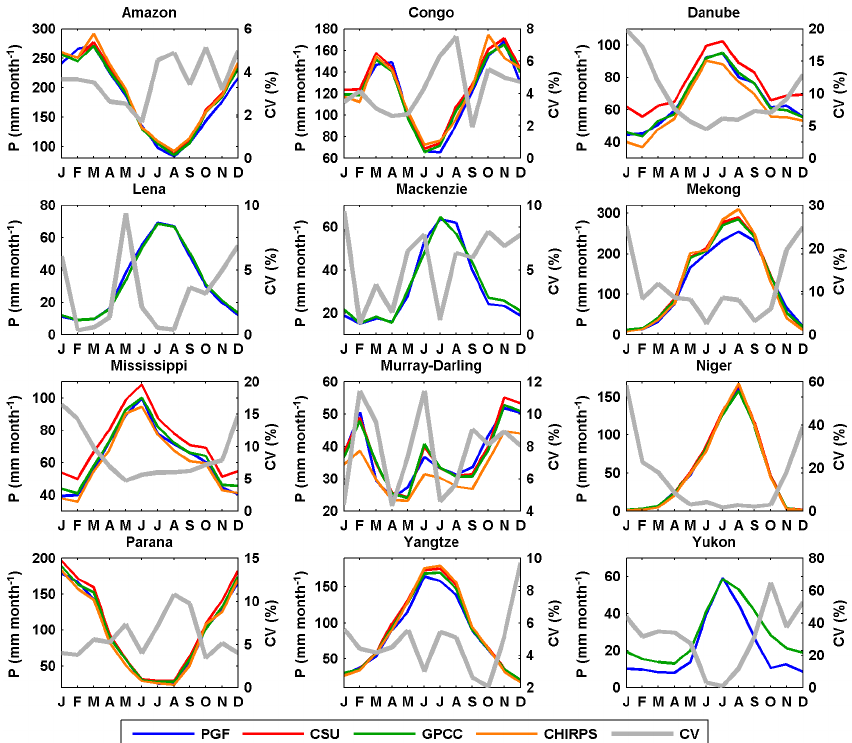
Figure 3. Seasonal cycles of precipitation from different products over 12 representative large basins for 1998–2010. (CHIRPS and CSU only cover the region between 50 ◦ N and 50 ◦ S. For those basins either outside or across 50 ◦ N–50 ◦ S, only PGF and GPCC are